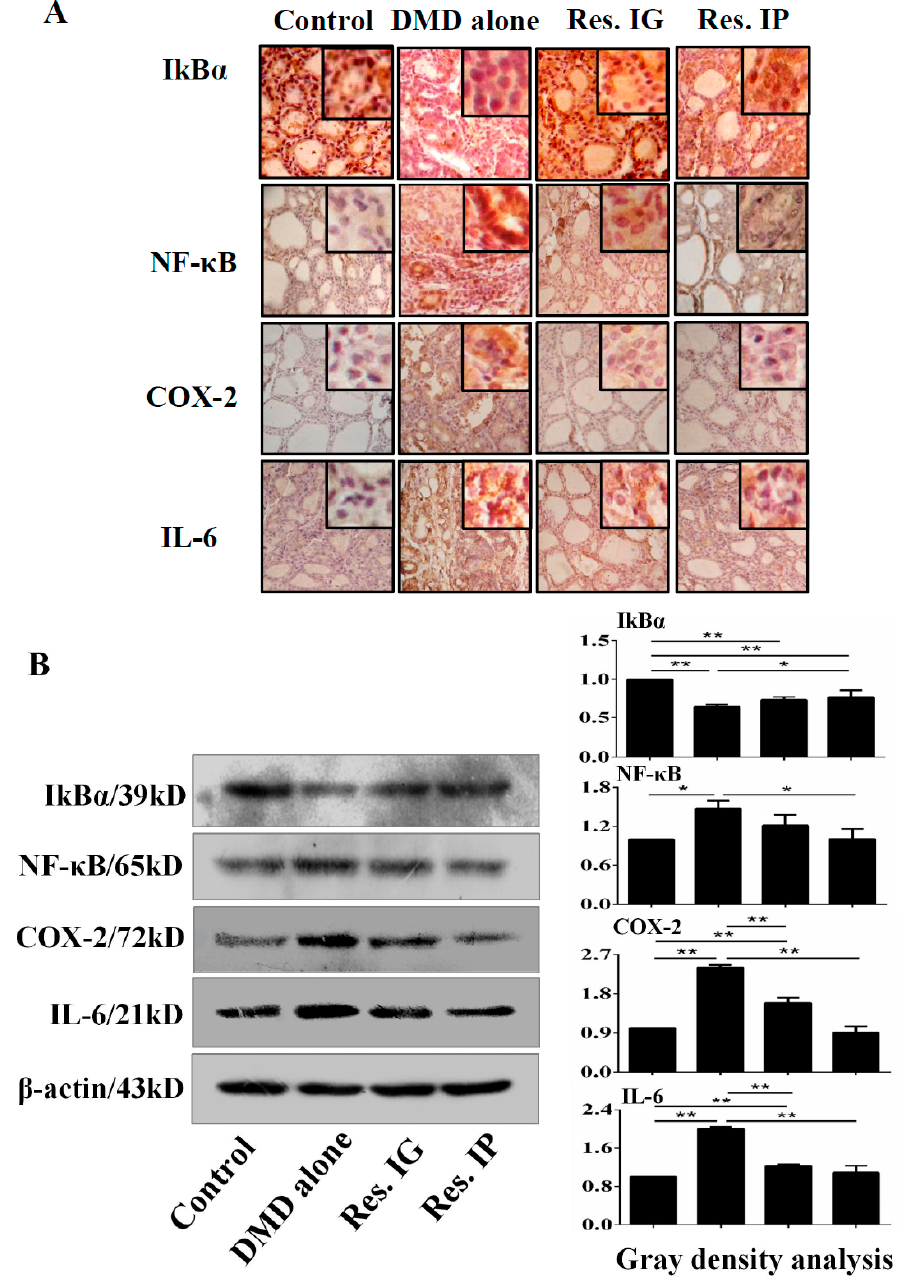
Figure 6. Effects of resveratrol on NF- κ B signaling and its associated protein production. ( A ) IkB α , NF- κ B, COX-2 and IL-6 immunohistochemical staining were performed on the Control, DMD alone, Res. IG and Res. IP groups; ( B ) Western blot analysis of IkB α , NF- κ B, COX-2, and IL-6 expression in four groups. β -actin was used as quantitative control, and the results were statistically analyzed relative to control group. *, p < 0.05; **, p < 0.01.